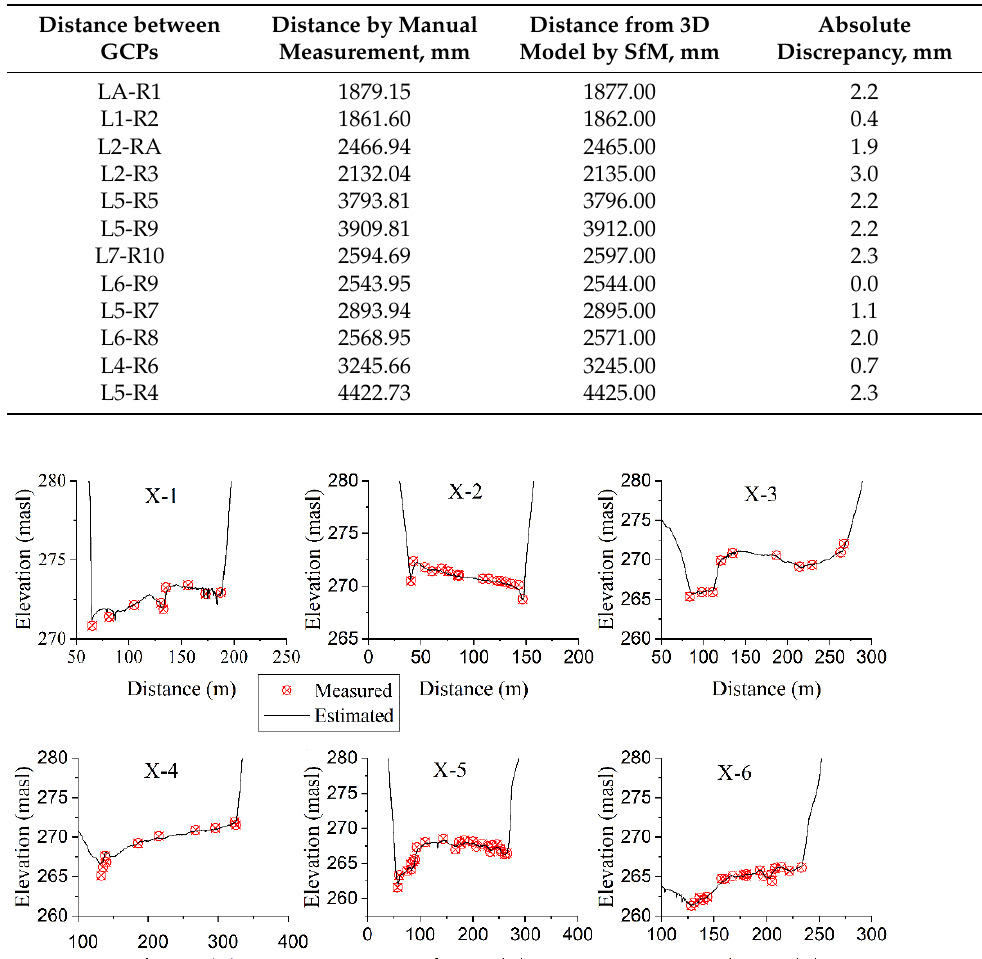
Table 2. Estimated errors in reproduction of selected distances in the 3D model by SfM, Case Study I.